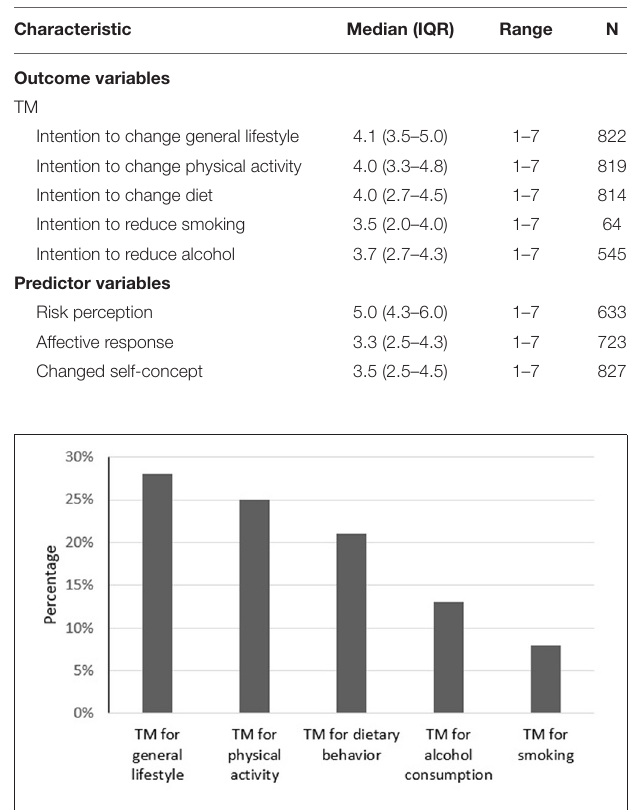
FIGURE 2 | Averaged mean score of ≥ 5 on TM outcome variables.